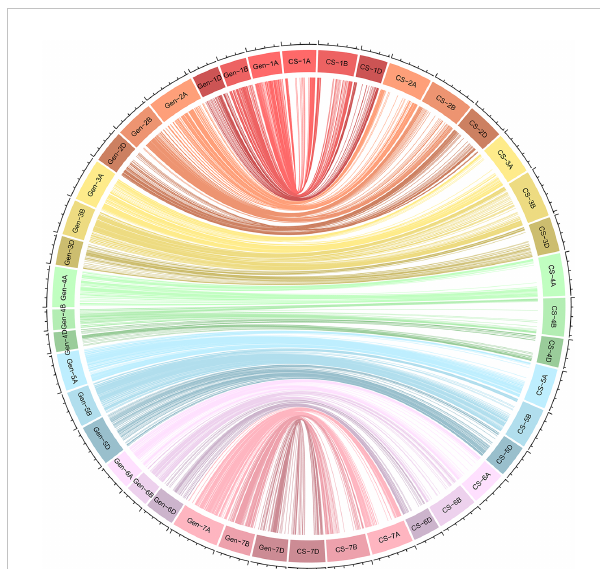
FIGURE 4 Schematic representation of the syntenic relationships between any one marker in wheat genetic and physical maps. Gen-1A to Gen-7D represent the 21 wheat chromosomal genetic maps released in this study; CS-1A to CS-7D represent the 21 wheat chromosomal physical maps of Chinese Spring reference genome. For the redundant loci that showed co-segregation in the 182 Xiaoyan 54/ Jing 411 RILs, only one unique informative marker is